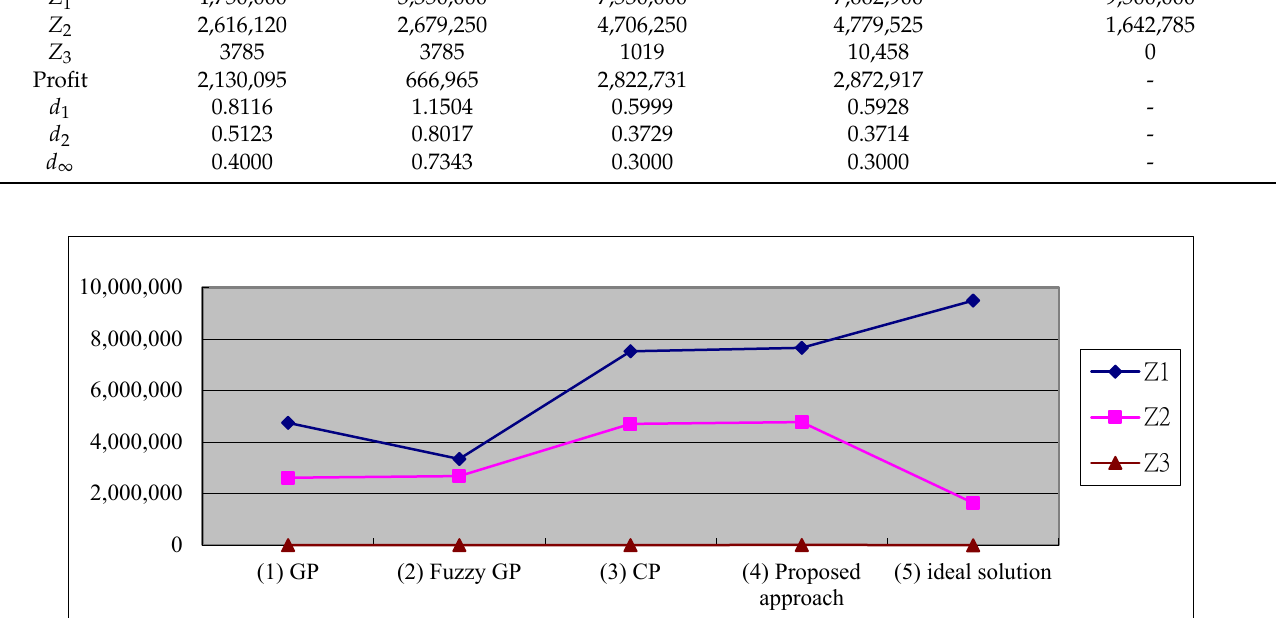
Figure 1. Graphical representation of the solutions by different approaches.